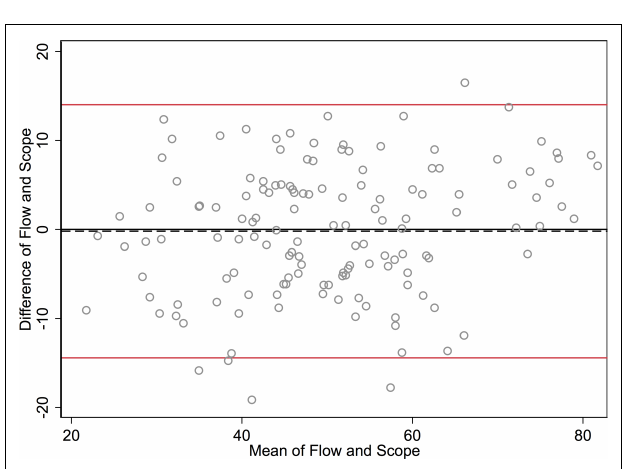
FIGURE 2 | Concordance scatter plot of machine fl ow cytometer neuron percent counts ( Y -axis, “Flow”) against microscope counts by a human ( X -axis, “Scope”) for the same 142 brain samples. Two lines are overlayed on the plot. The black line is the line of perfect concordance, Y = 1 × X + 0, or Y = X . The red line is the linear regression line, Y = 0.965 × X + 1.57. The 95% CI for the slope is from 0.873 to 1.057. The Lin concordance correlation is 0.86 (CI 0.82, 0.90).